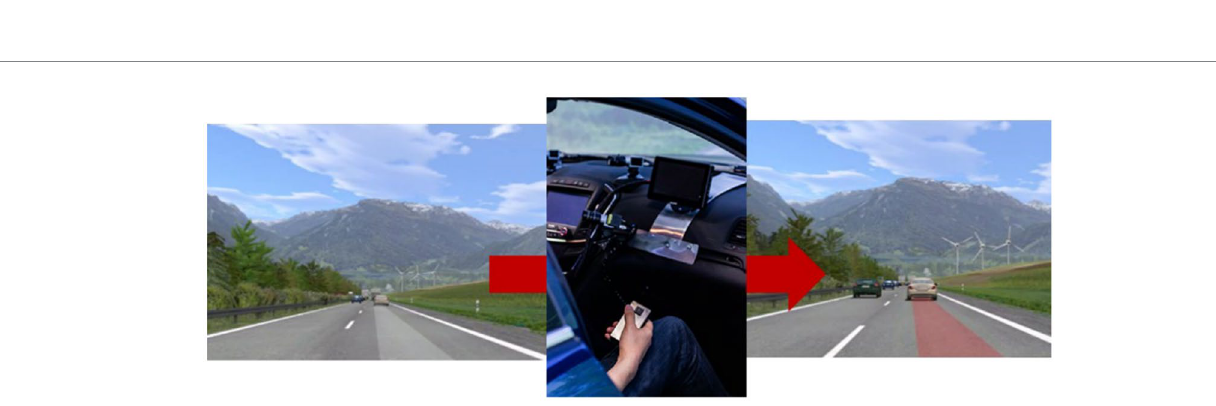
FIGURE 7 Active distance influence head-up display. Left: Head-up display when the passenger does not intervene. Middle: Passenger intervention using a handheld controller. Right: Head-up display after the passenger pressed the button, independent of actual